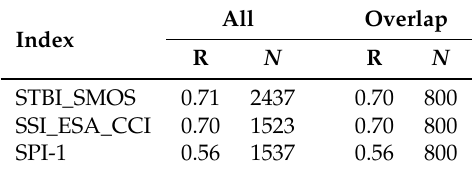
Table 2. Pearson R correlation coefficient between the SSI_LDAS and the, STBI_SMOS, SSI_ESA_CCI and the SPI-1. Computed for individual grid-cells (27 datapoints) and summed over the whole domain (all columns) and over grid-cells with overlap between all datasets (overlap columns). N indicates grid-cells with statistically significant correlation at the 0.05 level, total number of land grid-cells were 2997.